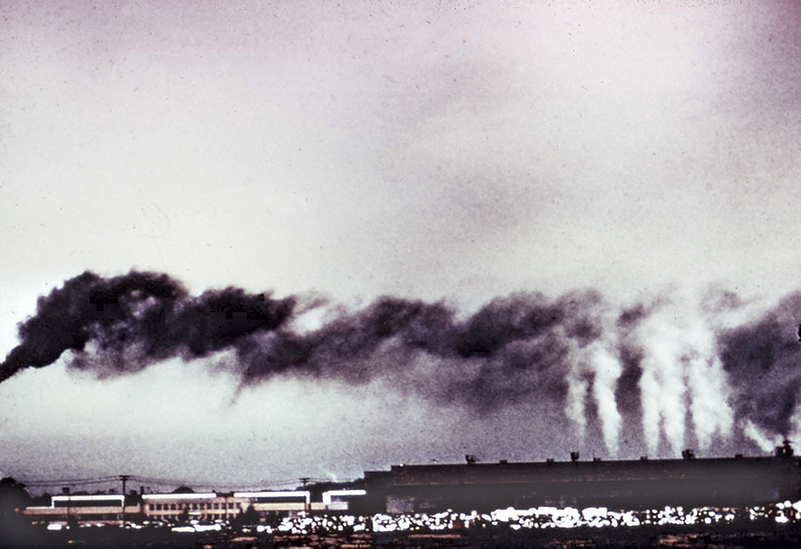
Historical air pollution in New Jersey (source: George and Carol Wolff; from presentation for Air Pollution Control Association, Middle Atlantic States Section, Newark, NJ, circa 1974).